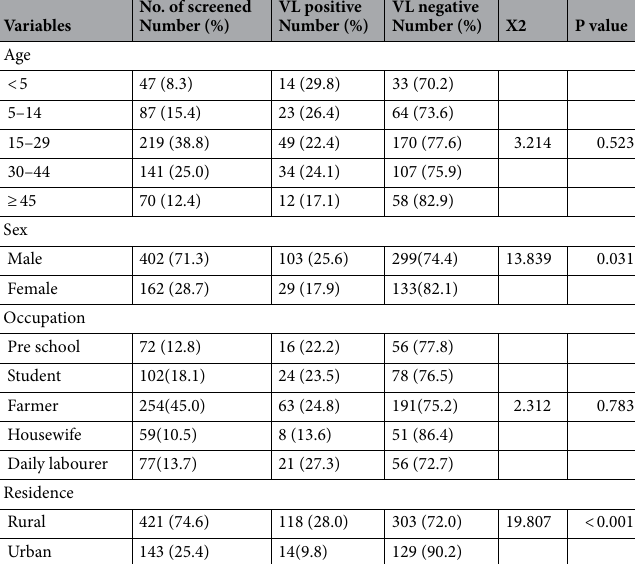
Table 1. Socio-demographic characteristics of the study participants in relation to VL at Tefera Hailu Memorial Hospital, Sekota, NortheastEthiopia from January 2017 to December 2021.